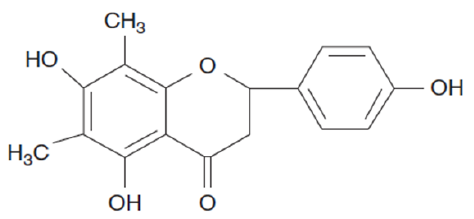
Figure 1. The chemical structure of